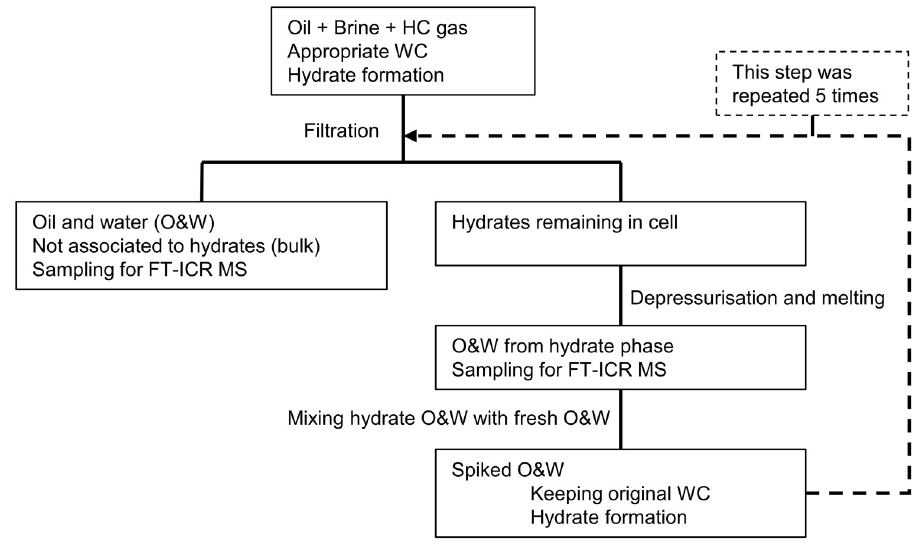
Fig 1. Schematic illustration of the successive accumulation experiment for spiking of the hydrate